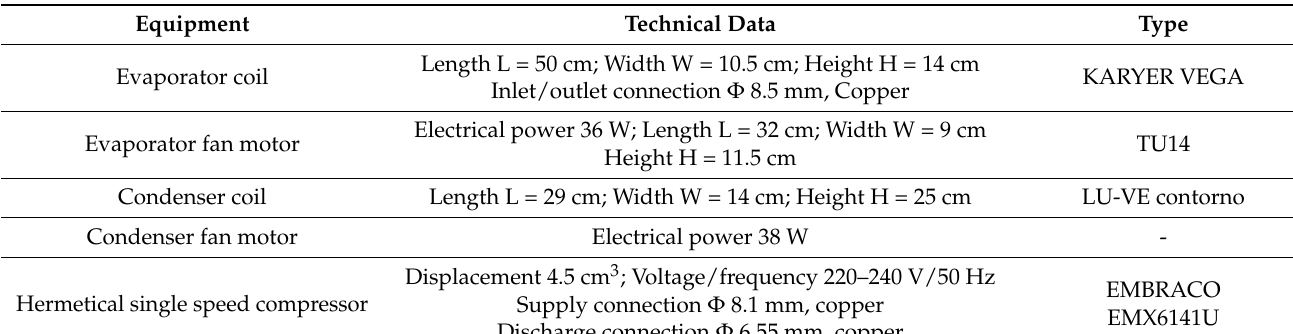
Table 4. Refrigeration system components.